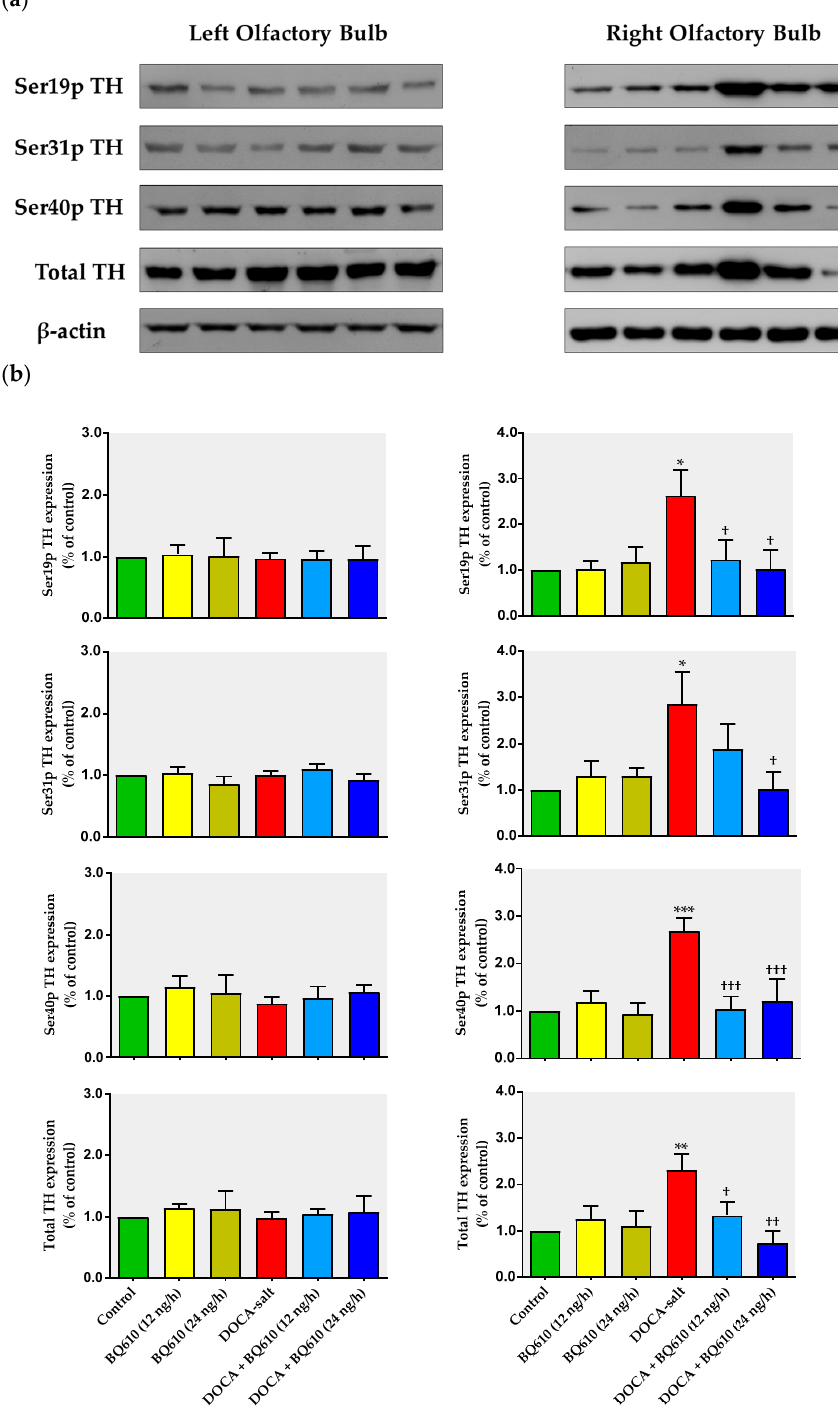
Figure 4. Expression of total tyrosine hydroxylase (TH) and its phosphorylated forms following ET A blockade in the left and right olfactory bulb of normotensive and DOCA-salt hypertensive rats. ( a ) Representative immunoblots; ( b ) Densitometric analysis of TH expression and its phosphorylated levels (Ser19p TH, Ser31p TH, Ser40p TH) in the left and right OB. Results are expressed as percentage of control ± SEM (% control). * p < 0.05, ** p < 0.01, and *** p < 0.001 vs. control; † p < 0.05, †† p < 0.01, and ††† p < 0.001 vs. DOCA-salt. Number of animals for each experimental group: 4.